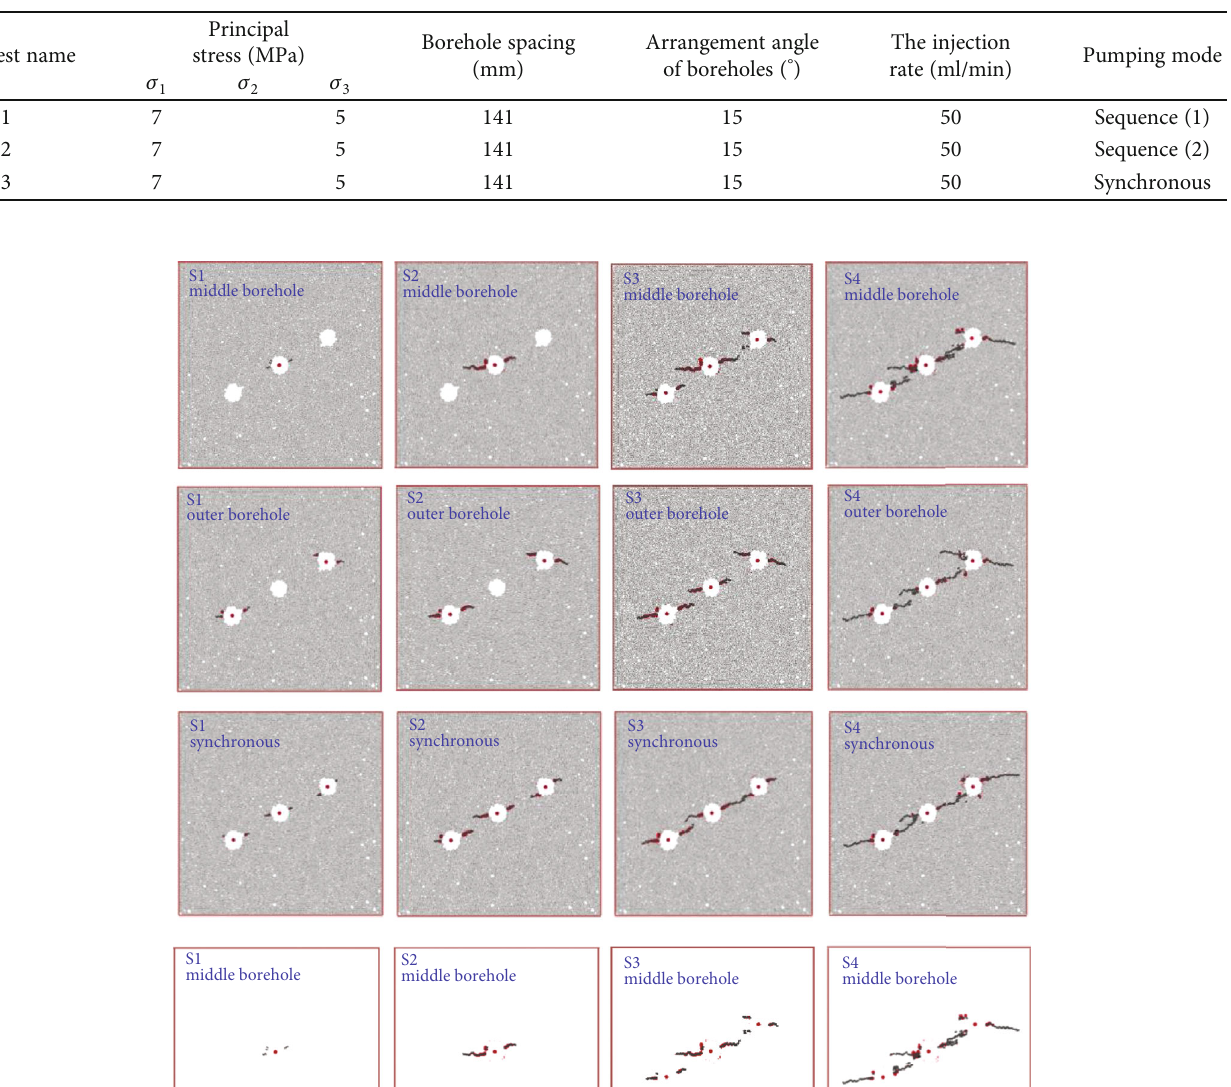
Table 7: Experimental scheme of directional hydraulic fracturing.